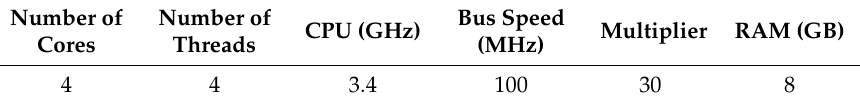
Table 3. The Hardware Configuration Used in the